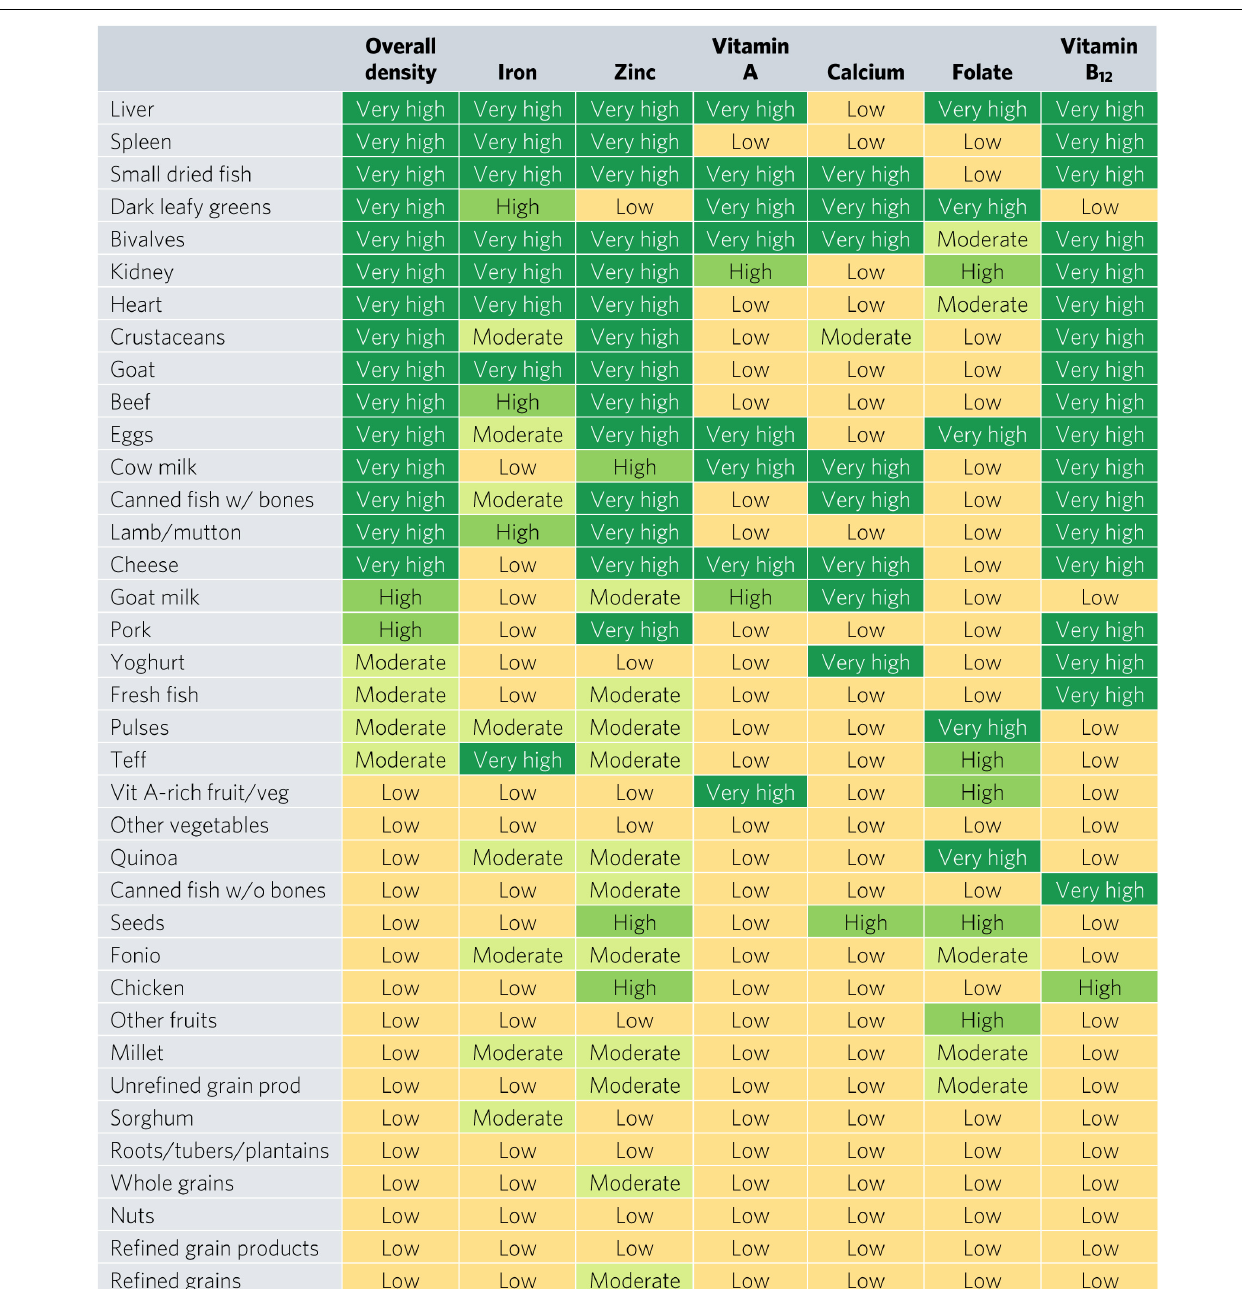
FIGURE 2 | Aggregate and individual micronutrient density scores for women of reproductive age. prod, products; veg, vegetables.